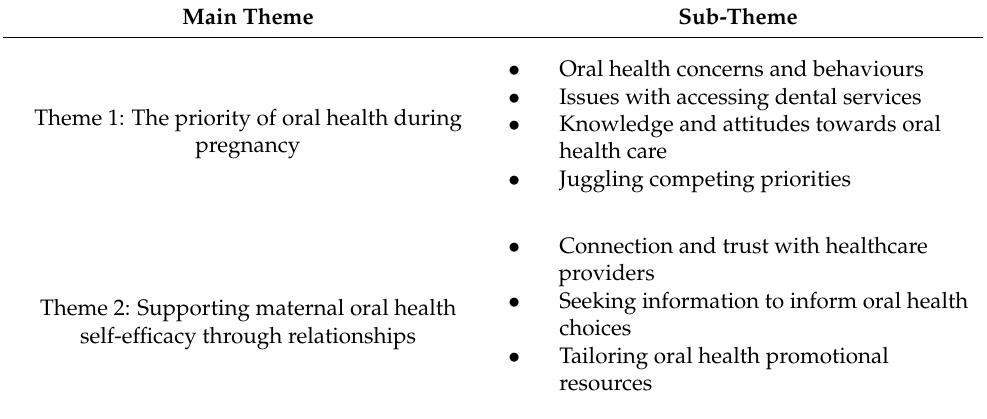
Table 1. Themes and